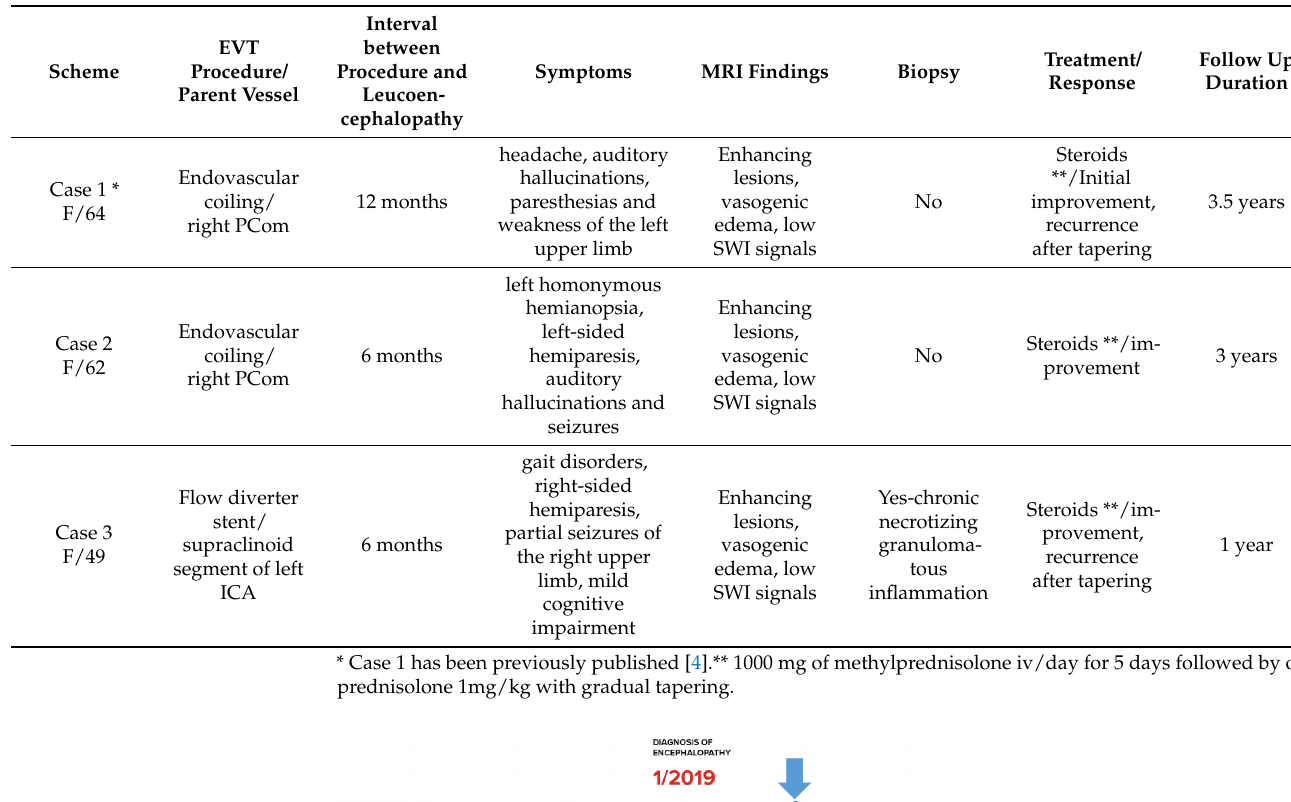
Table 1. Overview of described cases with delayed white matter lesions complicating endovascular therapy for intracranial aneurysms.